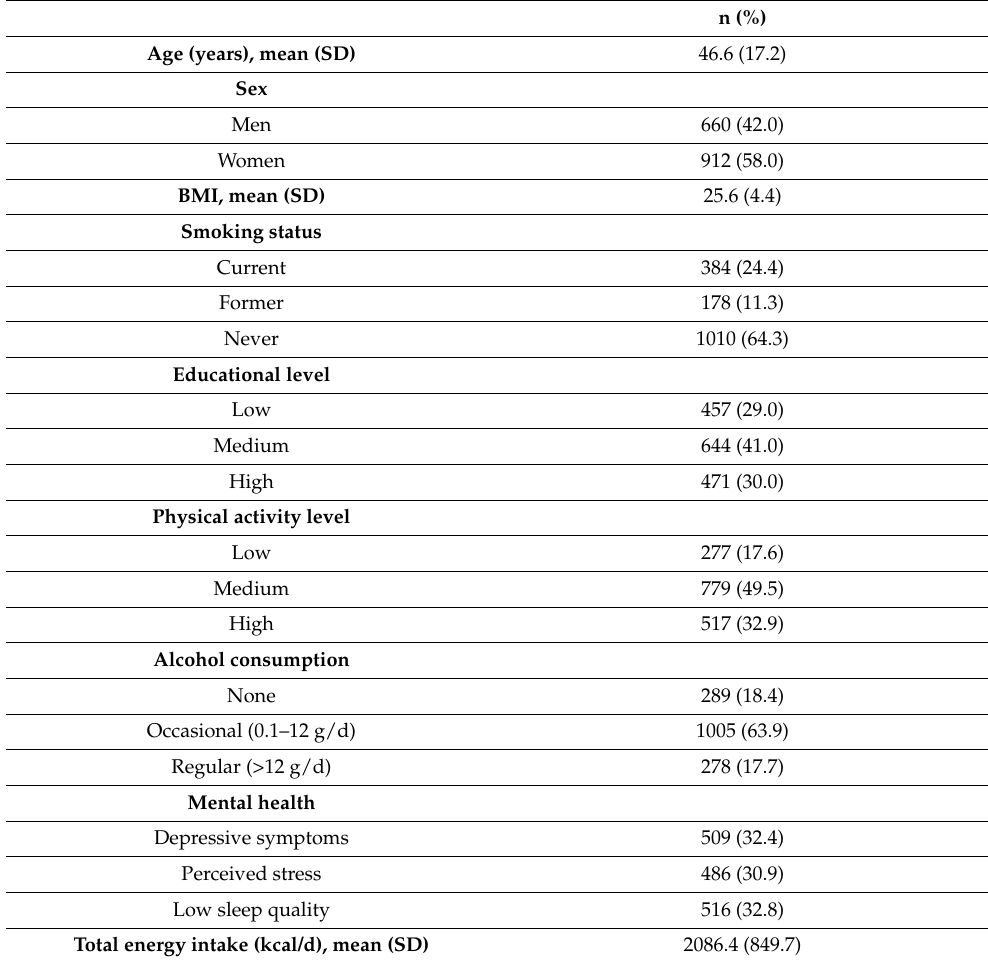
Table 1. Background characteristics of the study sample (n =